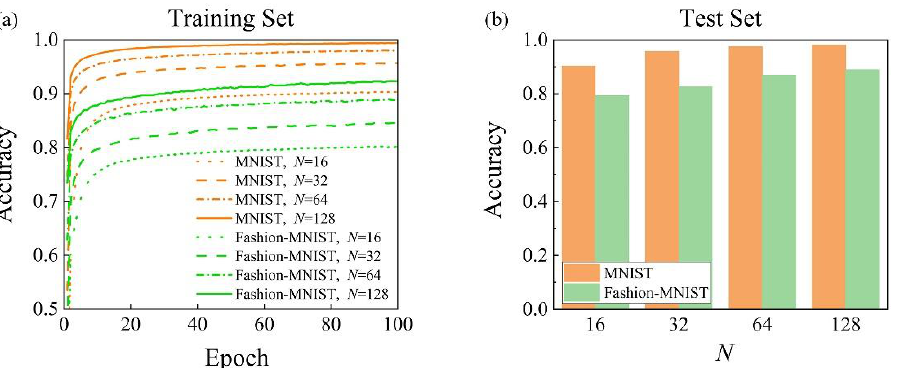
Figure 6. Classification accuracies of different sizes of single-core N × N PCNNs on the MNIST and Fashion-MNIST ( a ) training dataset and ( b ) test set.